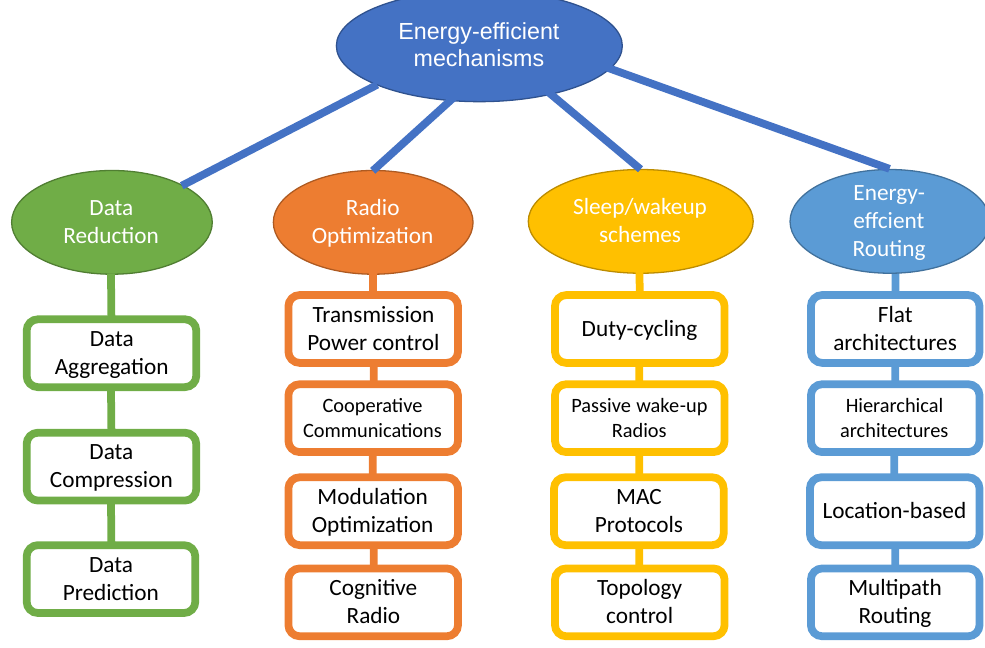
Figure 1. Taxonomy of energy-efficient mechanisms proposed in